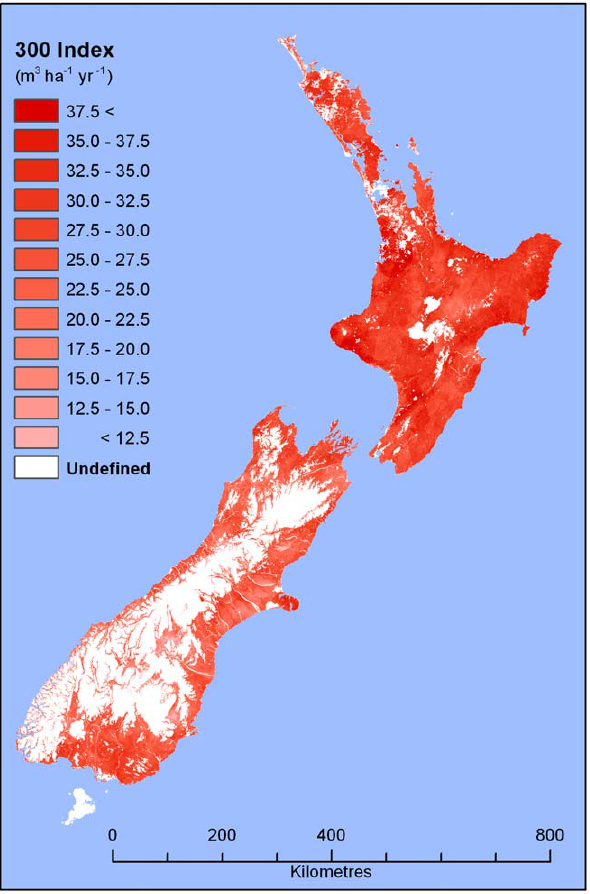
Figure 1. Spatial variation in 300 Index (mean annual volume increment at age 30 for a standard regime grown at 300 stems ha 2 1 ) for Pinusradiata in New Zealand [ 32 ] . Projection: New Zealand map grid.